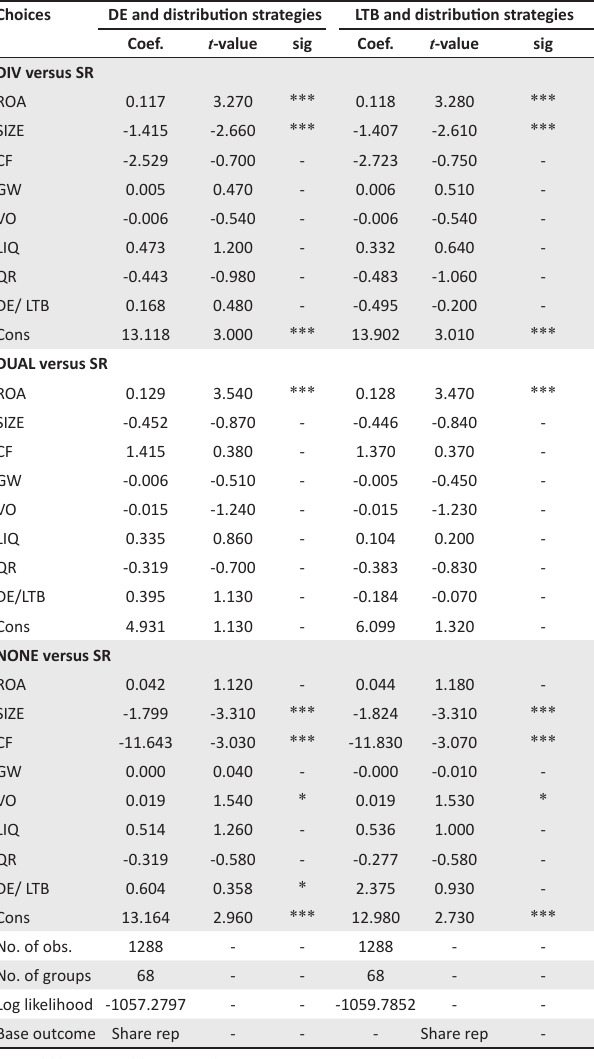
TABLE 5 : Pooled multinomial logistic regression estimation. Choices DE and distribution strategies LTB and distribution strategies Coef.